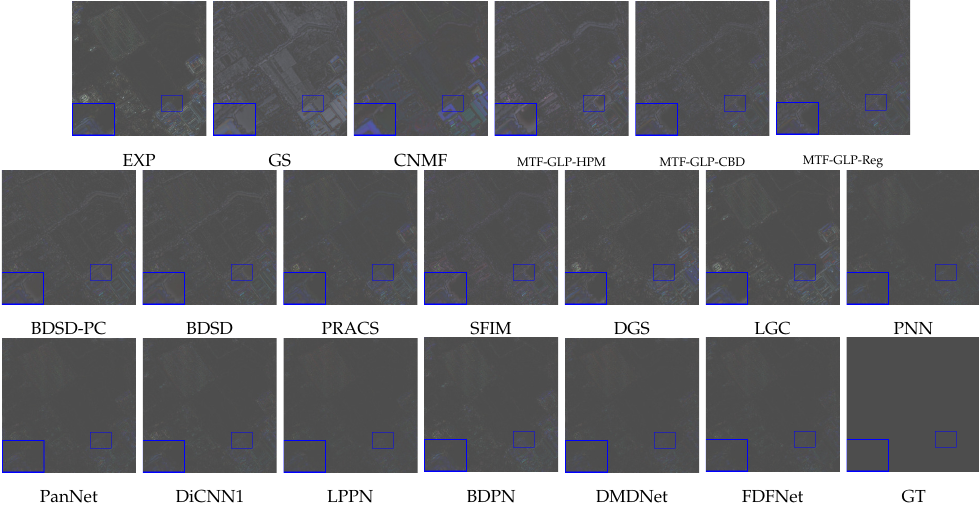
Figure 10. The visual comparisons of the corresponding residual maps using the GT image as reference (shown by bands: 1, 3, and